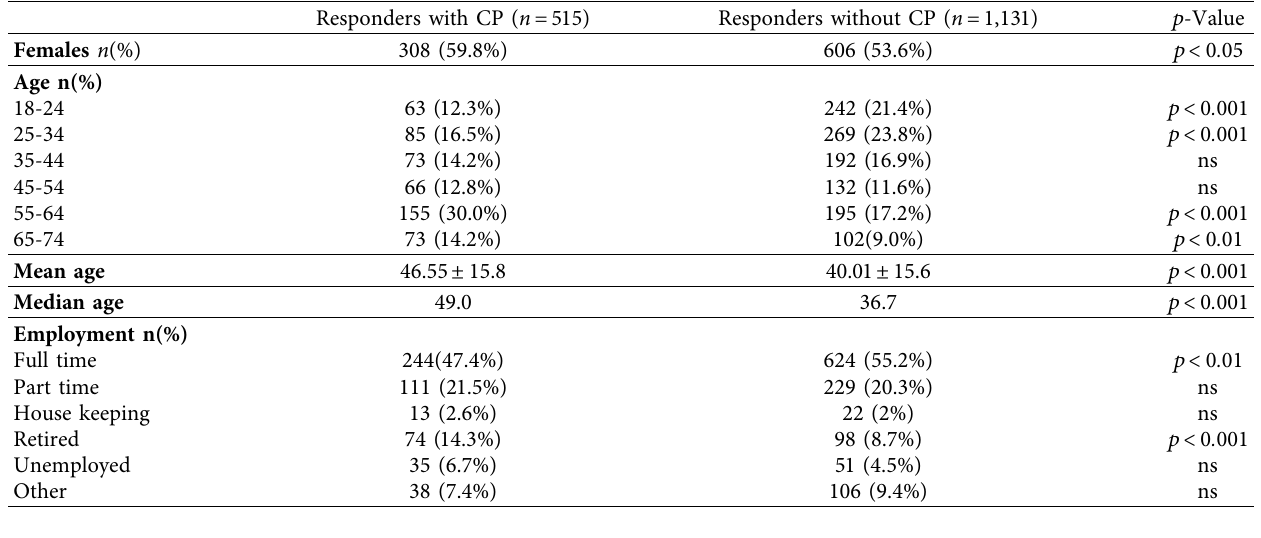
Table 1: Demographic characteristics of responders with or without chronic pain.